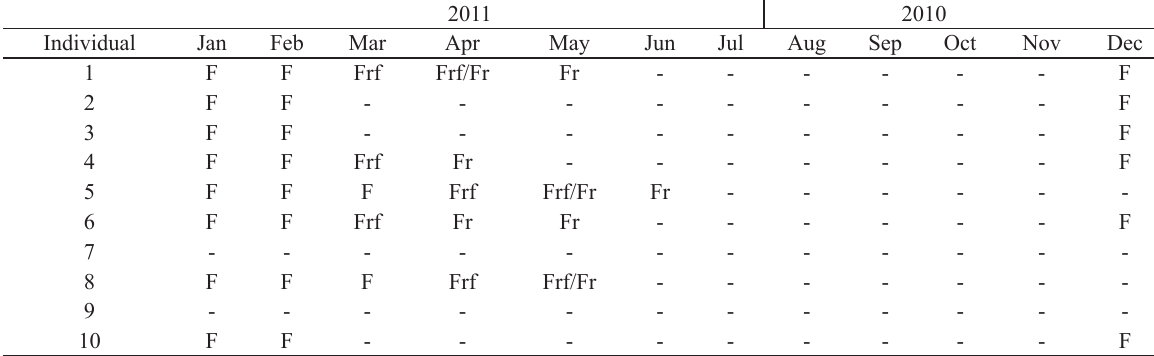
Reproductive phenology of 10 individuals of the plant Dahlstedtia pinnata monitored between August 2010 and August 2011 in Pedra Branca State Park in Rio de Janeiro. F = flowers, Frf = fruits in formation, Fr = fruits formed, - = absence of reproductive